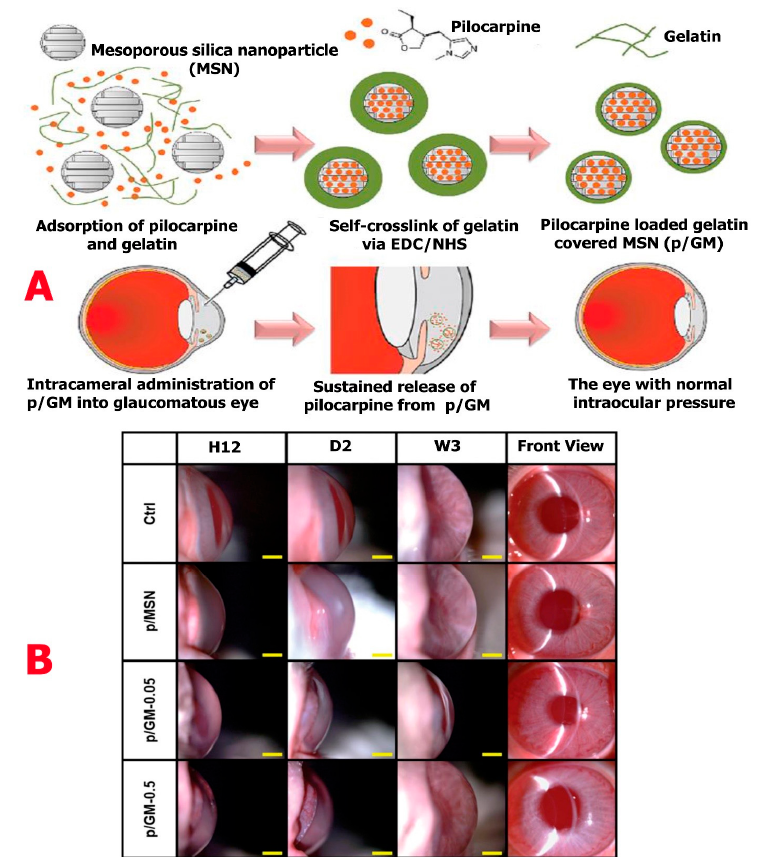
Figure 6. ( A ) Pilocarpine-loaded gelatin-covered mesoporous silica nanoparticles (p/GM) designed